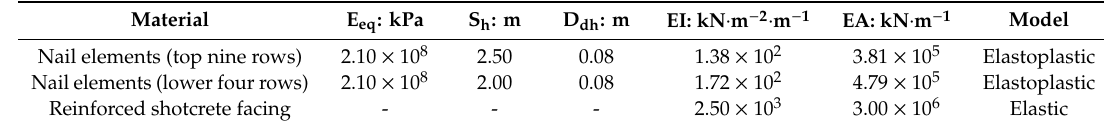
Table 2. Material properties for flexible facing and soil nail elements.